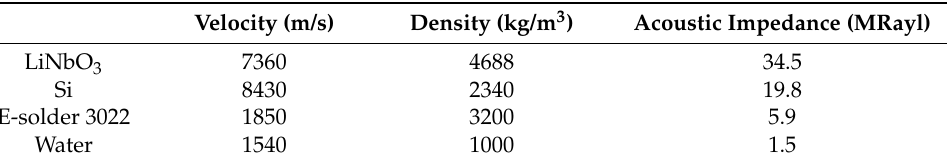
Figure 2. ( a ) Schematic diagram of lens design ; ( b ) 2D axisymmetric model of transducers based on a silicon lens. Table 2. The parameters of materials in the COMSOL simulation.